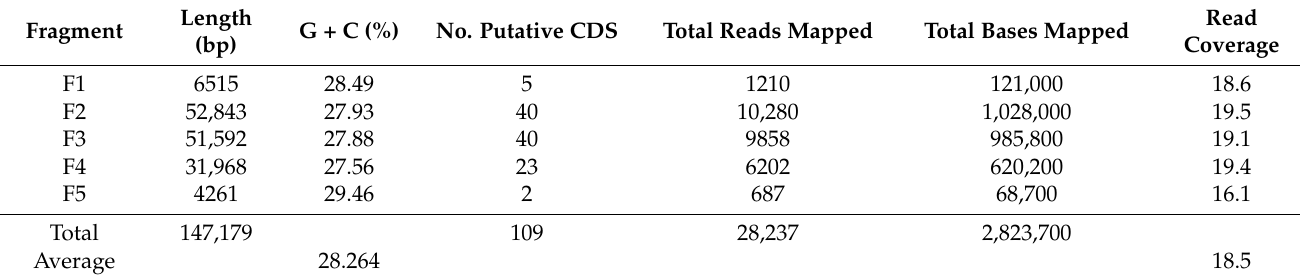
Table 3. Sequence read coverage of five nudivirus genomic fragments (F1 to F5) from D. undecimpunctata .